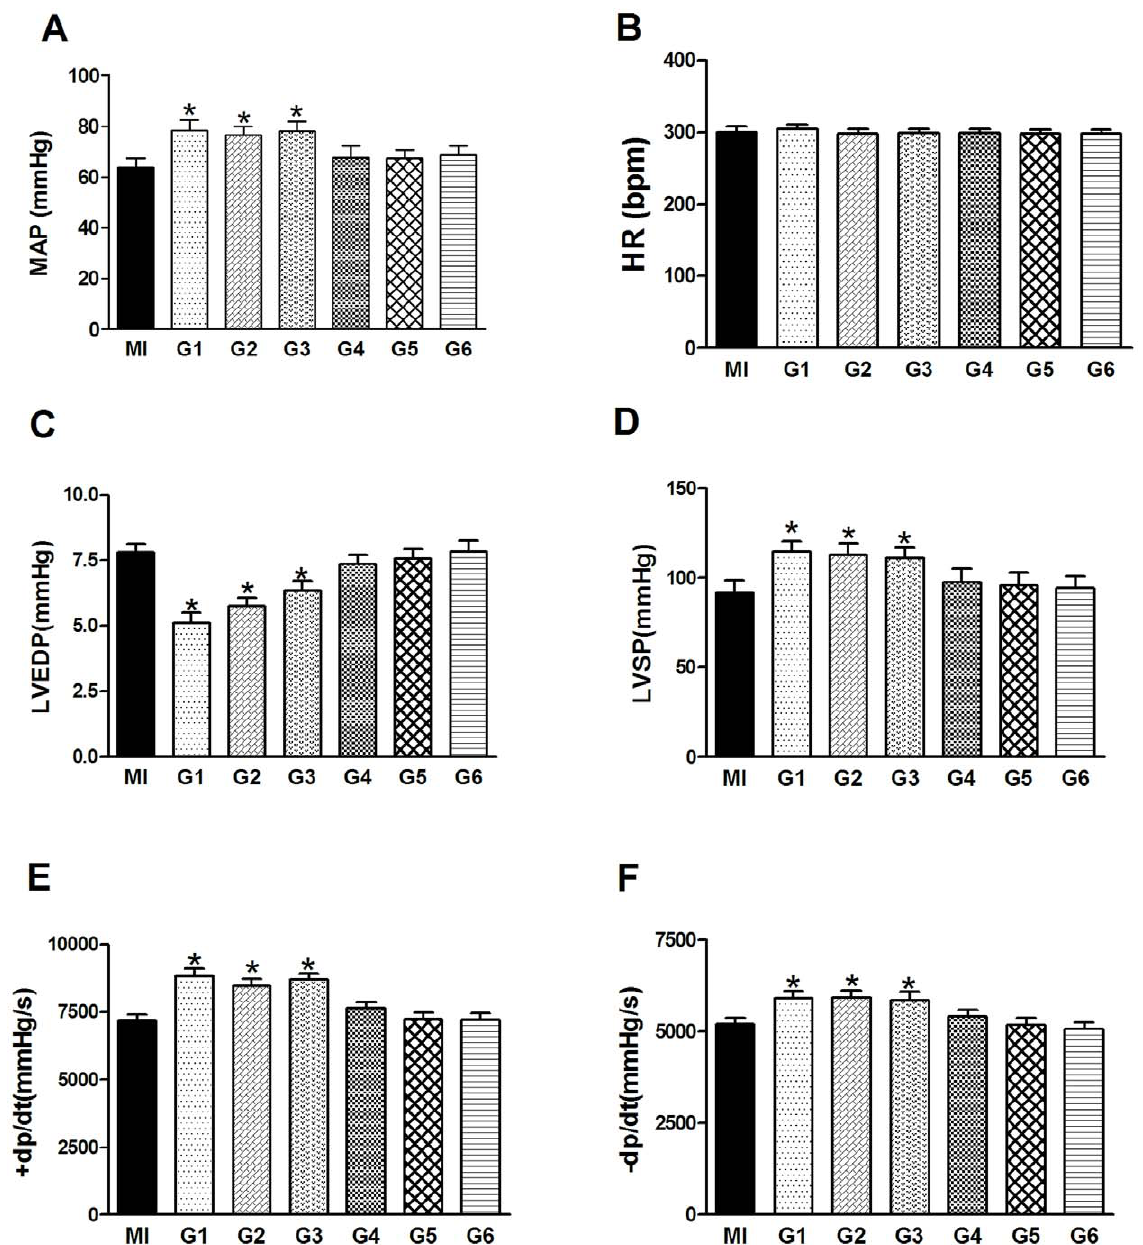
Figure 5. Effects of vagus nerve stimulation (VNS) on cardiac function in MI and G1–G6 group. MAP, mean arterial pressure; HR, heart rate; LVSP, left ventricular systolic pressure; LVEDP, left ventricular end-diastolic pressure; 6 dP/dt, maximum slope of systolic pressure increment and diastolic pressure decrement. Data are the mean 6 SEM (n=8 for each group). * P , 0.05 compared with MI control group.